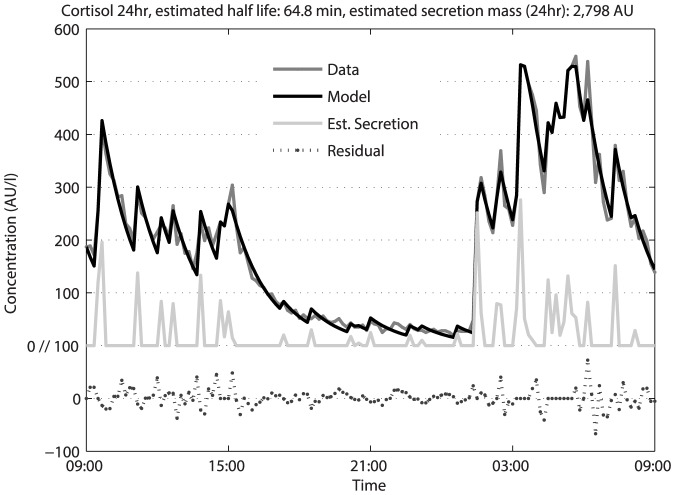
Twentyfour-hour cortisol concentration profile in a healthy obese woman.The secretion amplitude and timing were estimated by VisPulse which is a mathematical model with minimal assumptions, only an exponential decay is assumed and the secretion is assumed to be episodic. The latter is interpreted to mean that only a limited set of time points are involved in the episodic secretion, no assumptions are made about the distribution of the secretion. The residuals are without significant autocorrelation.